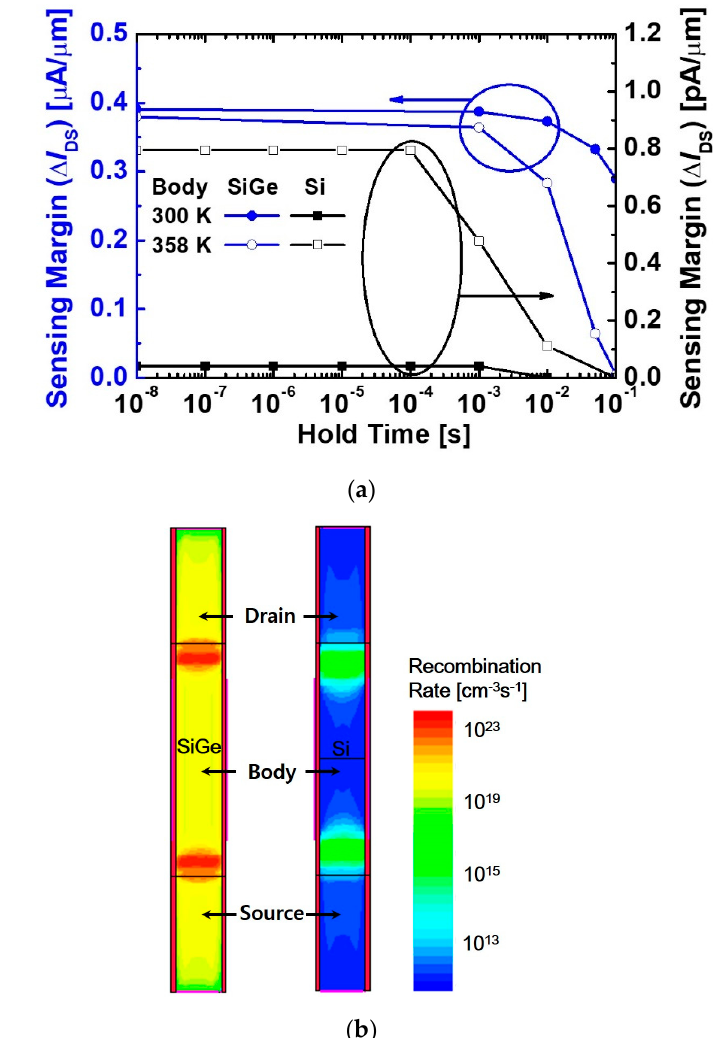
Figure 9. ( a ) Comparison of sensing margins as functions of hold time between 1T-DRAMs with Si and SiGe body at temperatures of 300 K and 358 K. ( b ) Recombination rates in 1T-DRAMs with Si and SiGe body for the hold operation at the ‘1’ state (hold time = 10 ns) and temperatures of 300 K.